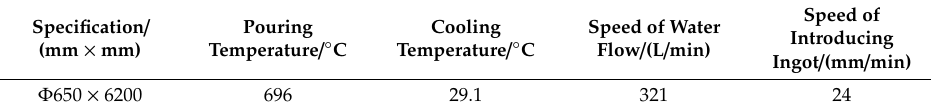
Table 2. Casting parameters of aluminum alloy ingot.